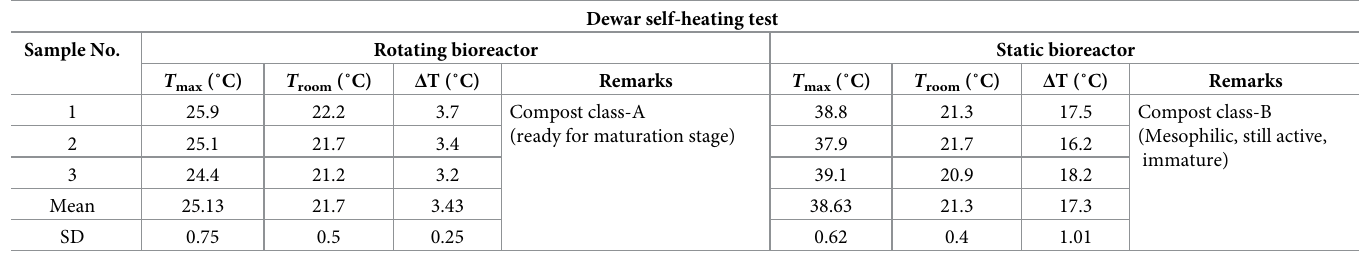
Dewar self-heating test